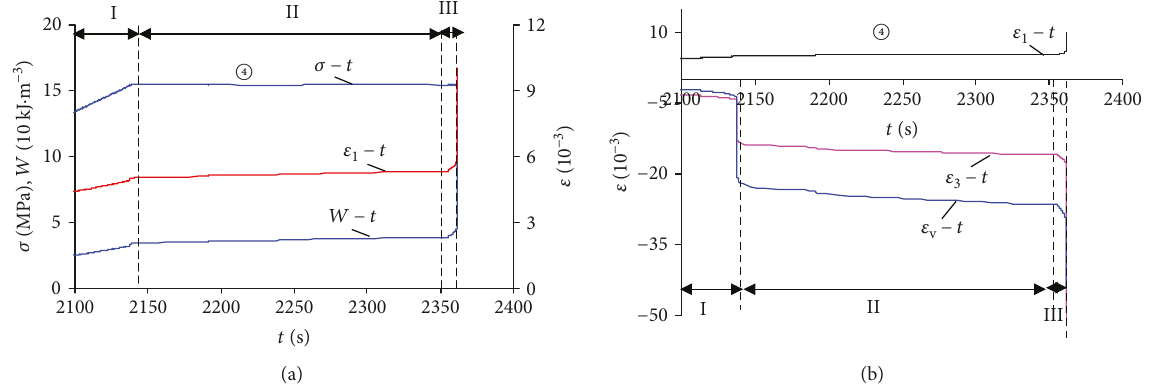
Figure 8: Stress (strain, energy) versus time curves for the step loading